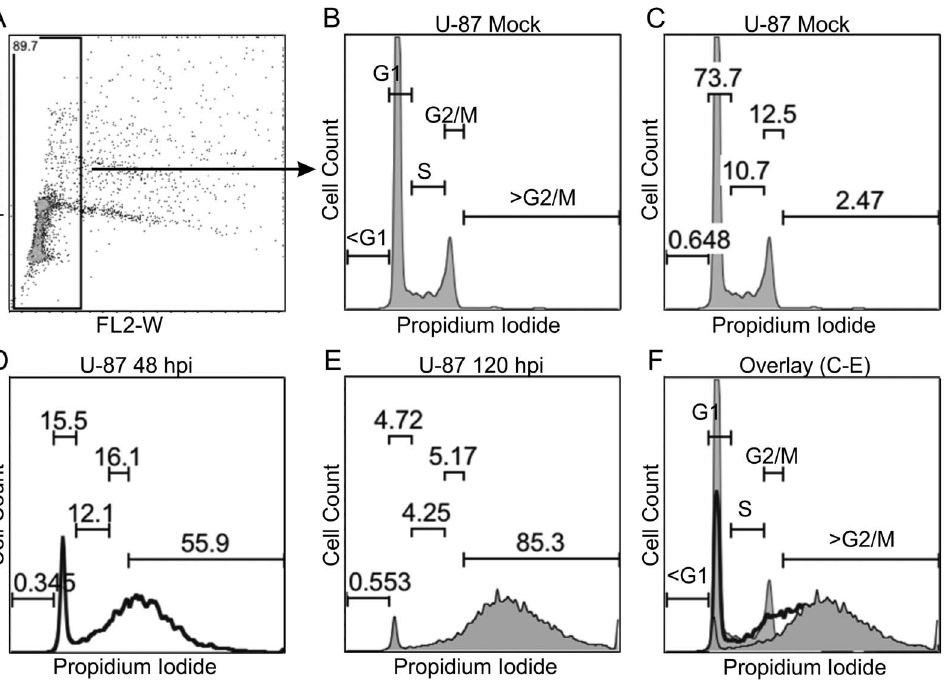
Figure 3. Quantification of cell cycle phases. ( A–F ) Cells were treated and cycle phases analyzed as described in Materials and Methods. ( A ) All the cells were gated to reduce doublets by selection of cells within the inset rectangular box. ( B ) Mock-infected cells in the cell cycle phases G1, S, G2/ M, , G1, and . G2/M are depicted. ( C ) Proportion of mock-infected cells in each phase of the cell cycle. ( D, E ) Representative plots and percentages of U-87 cells 48 ( D ) and 120 (E) hpi. ( F ) An overlay of plots C–E.